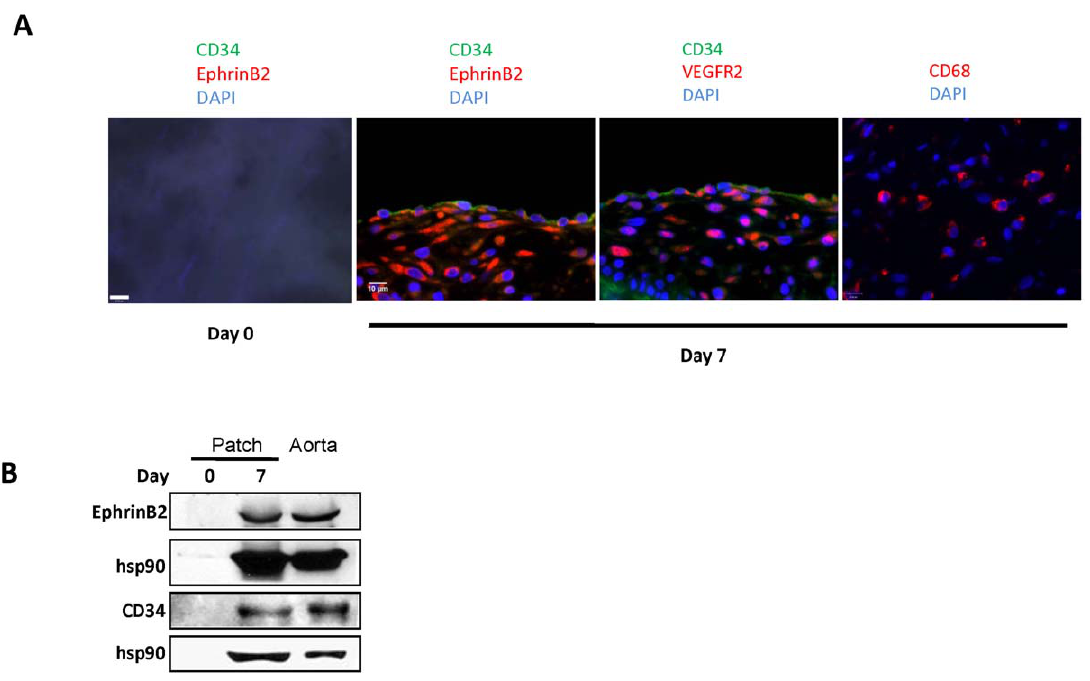
Figure 4. Porcine pericardial patches, day 7. A ) Porcine pericardial patches show infiltrating cells positive for CD34, Ephrin-B2, VEGFR2, or CD68; CD34-positive cells are present as a surface monolayer, with some cells dually positive for CD34 and Ephrin-B2 or CD34 and VEGFR2; first panel is the day 0 (preimplantation) control. Photomicrographs of immunofluorescence: blue color, DAPI; green color, CD34; red color, Ephrin-B2 or VEGFR2; merge, green + red. n=3; representative pictures are shown. Scale bar, 10 microns. B ) Western blot of Ephrin-B2 and CD34, in porcine pericardial patch, day 0 (preimplantation) or day 7.